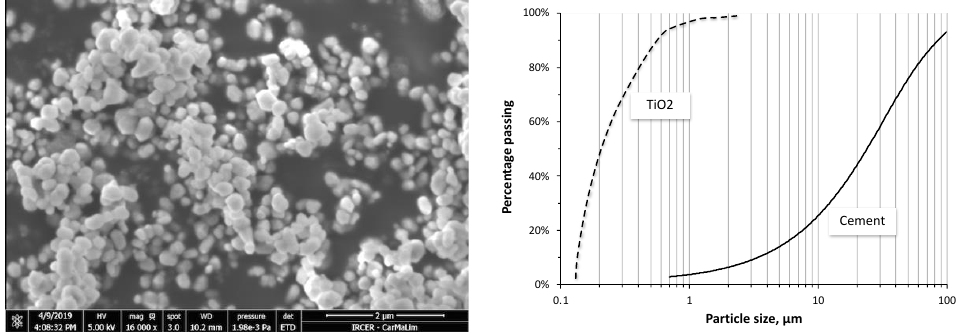
Figure 1. Morphology ( left ) and particle size distribution ( right ) of TiO 2 particles.